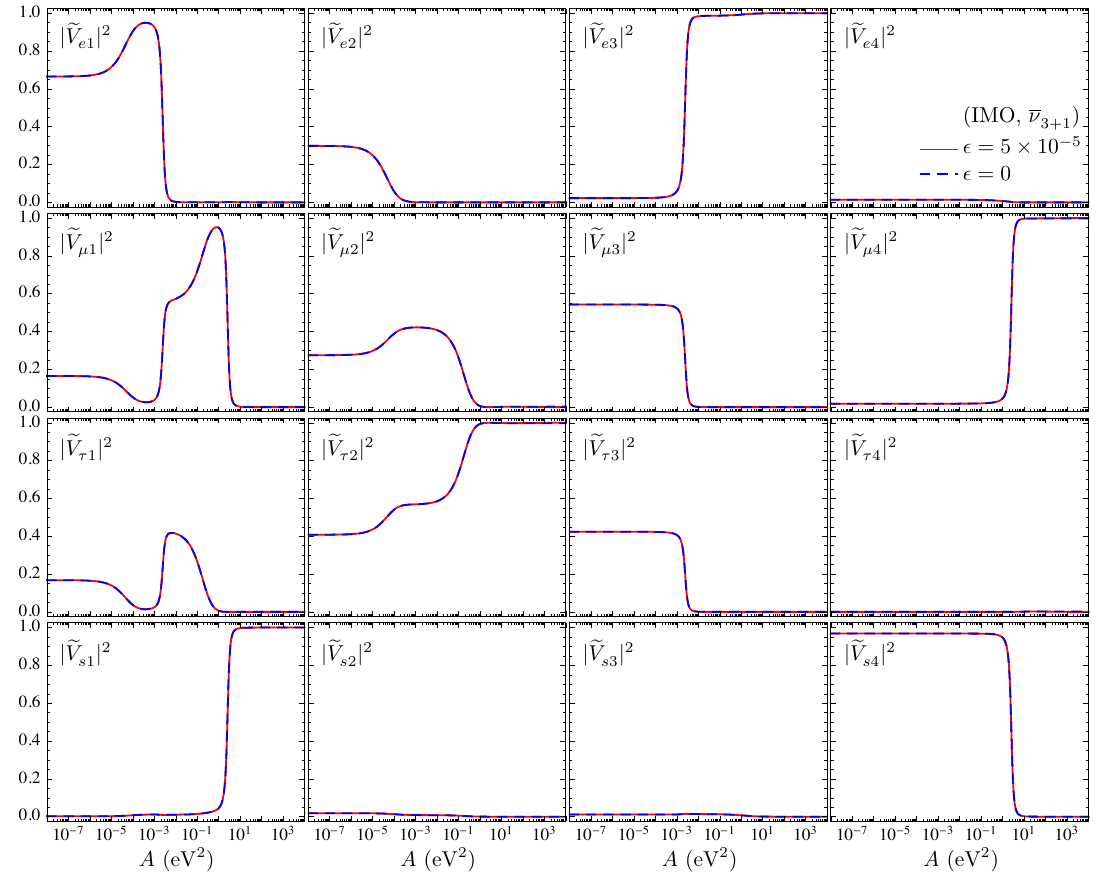
Figure 12 . In the (3 + 1) mixing scheme, the illustration of how